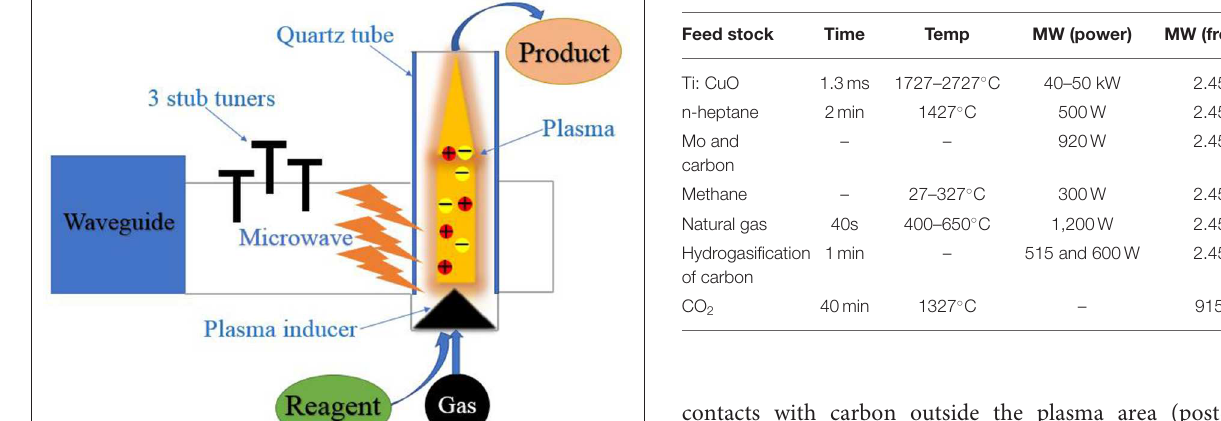
TABLE 2 | Summary of the microwave